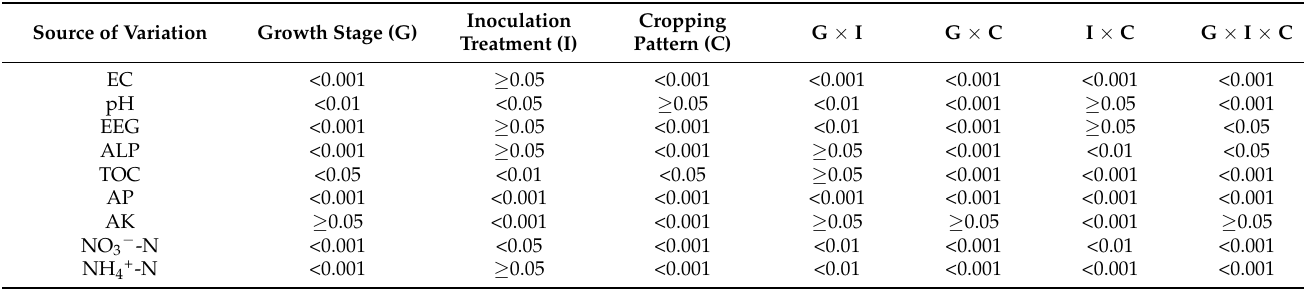
Table 1. Three-way ANOVA showing the effect of growth stage, inoculation treatment, cropping pattern, and their interactions on electrical conductivity (EC), pH, easily extractable glomalin (EEG), Alkaline phosphatase (ALP), Total organic C (TOC), Available P (AP) available K (AK), NO 3 − -N and NH 4+